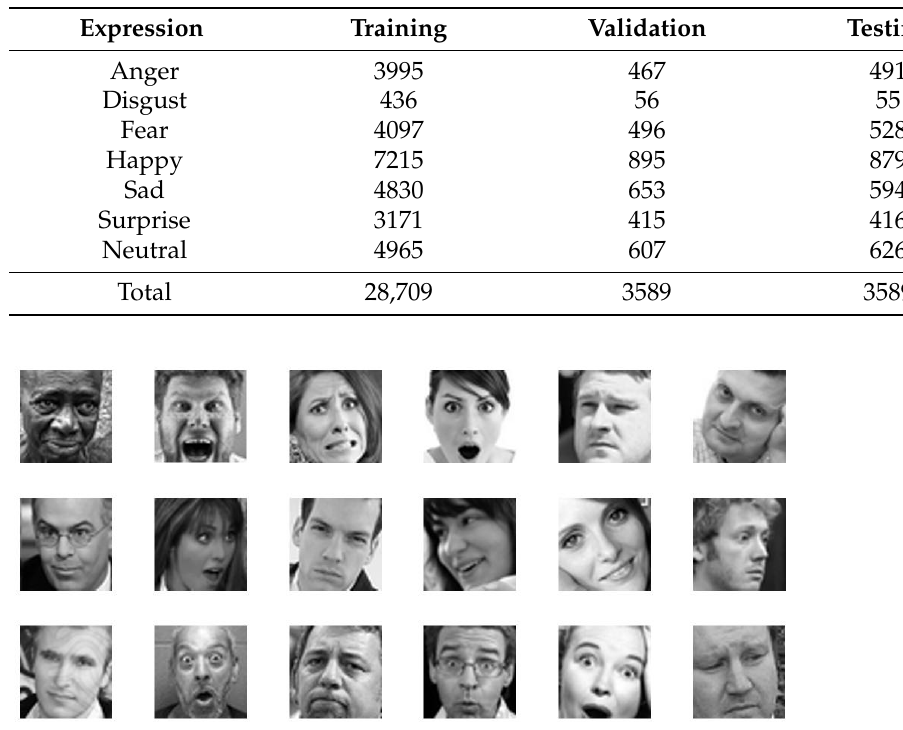
Table 1. Distribution of facial expressions in the FER-2013 dataset.